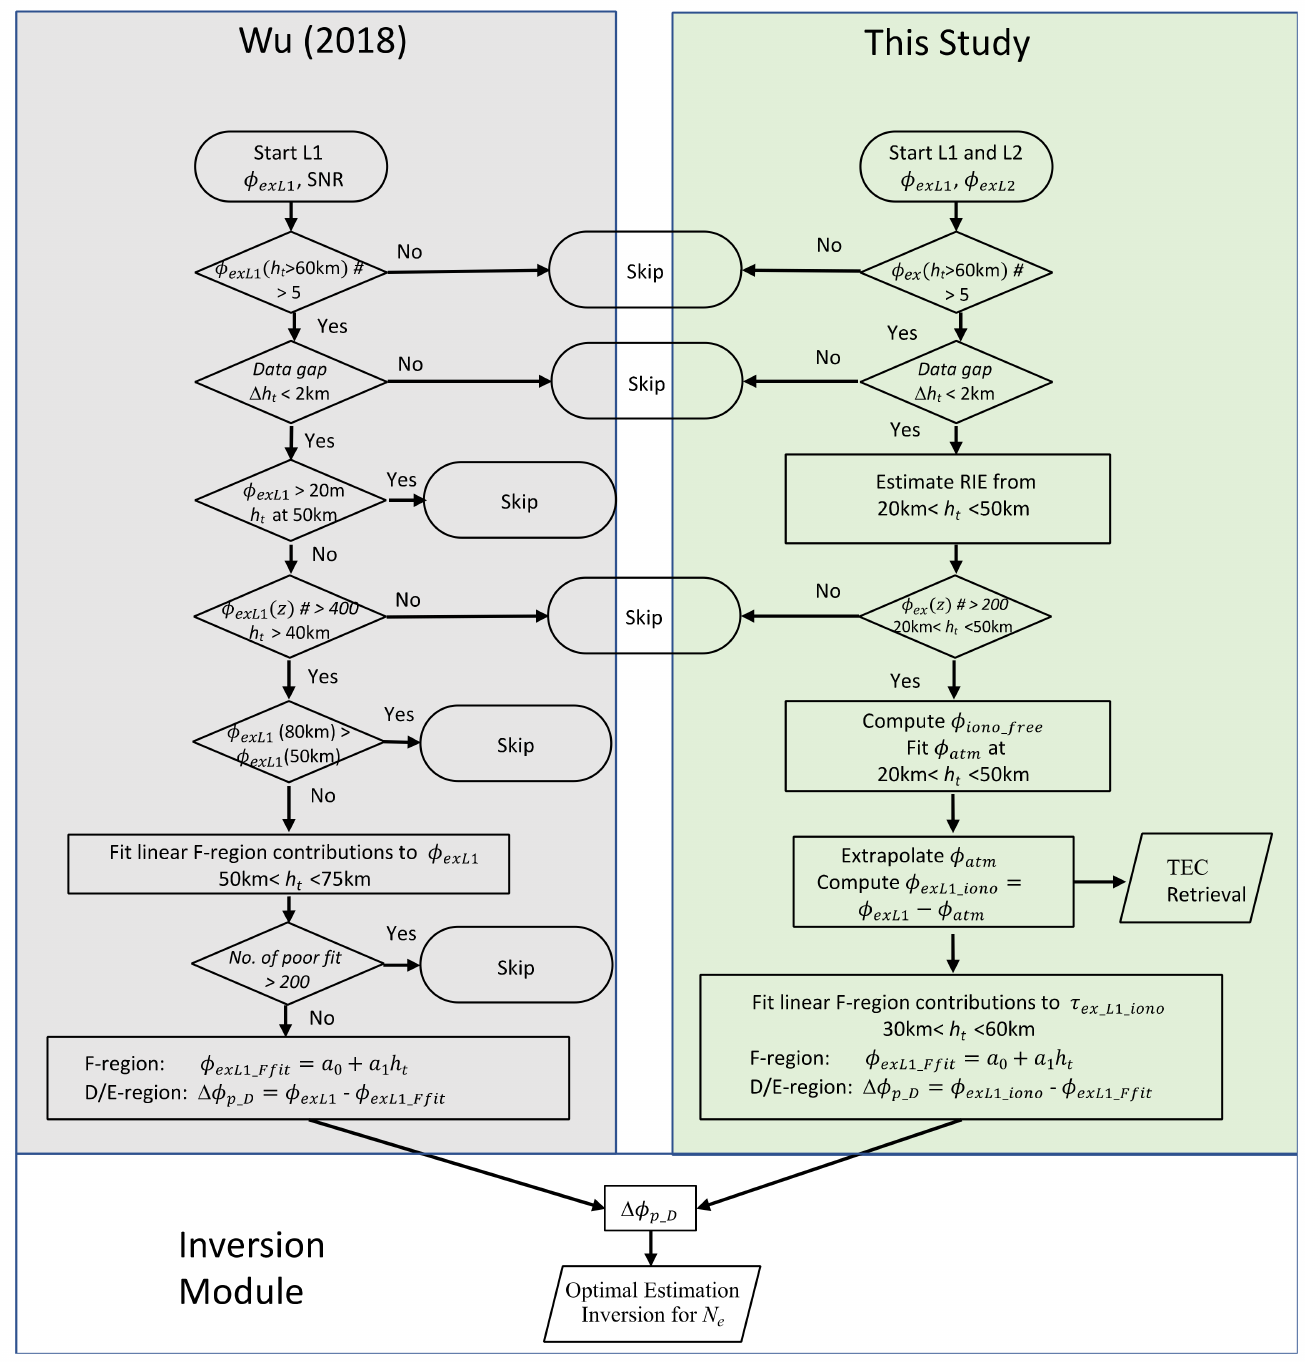
Figure A1. Algorithm flow diagram in this study in comparison with the algorithm developed earlier by Wu